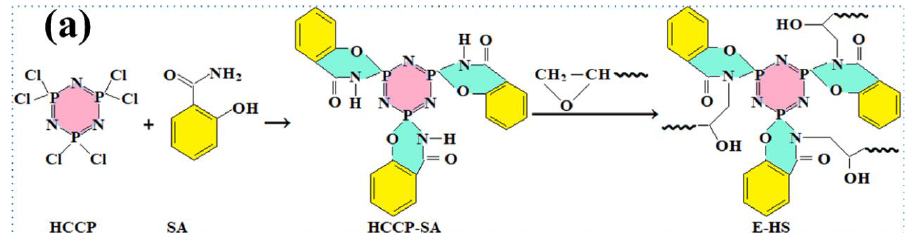
128 Figure 1. Synthesis route ( a ) and SEM ( b – c ) of HCCP and HCCP-SA; the inset shows the element 129 content measurement result by